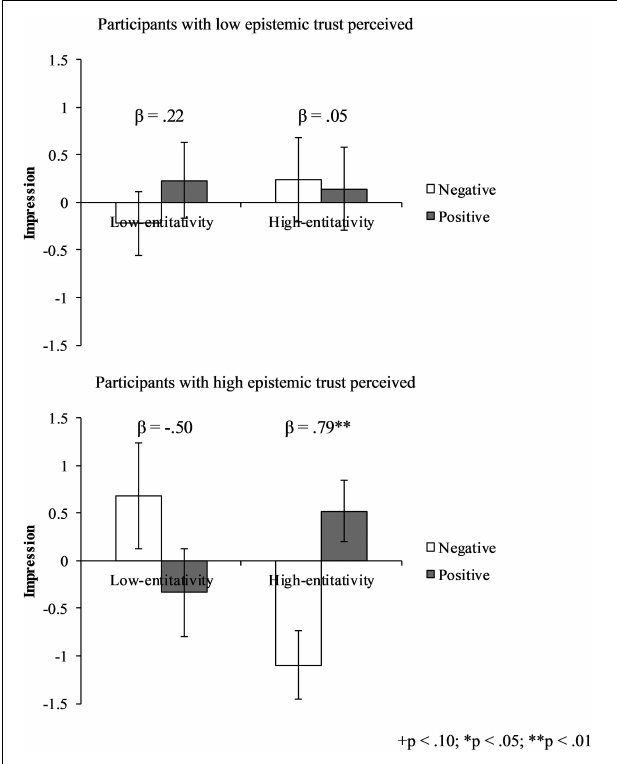
FIGURE 3 | Effect of audience attitude, audience group entitativity, and epistemic trust on